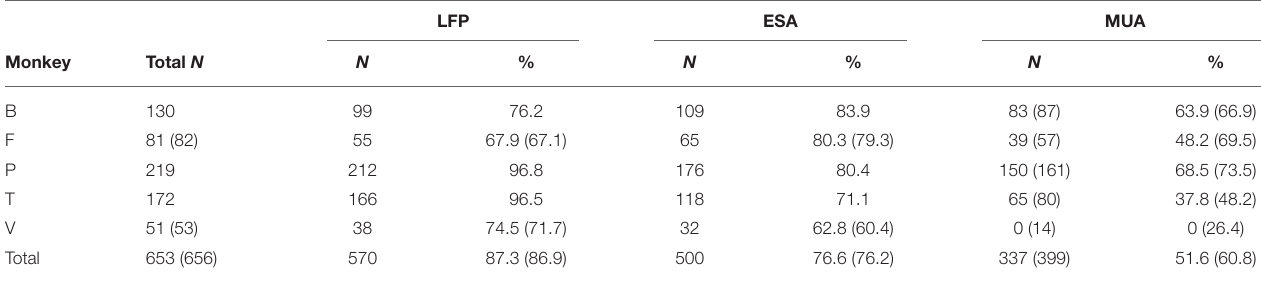
TABLE 1 | Number of detected RFs for individual subjects and signal